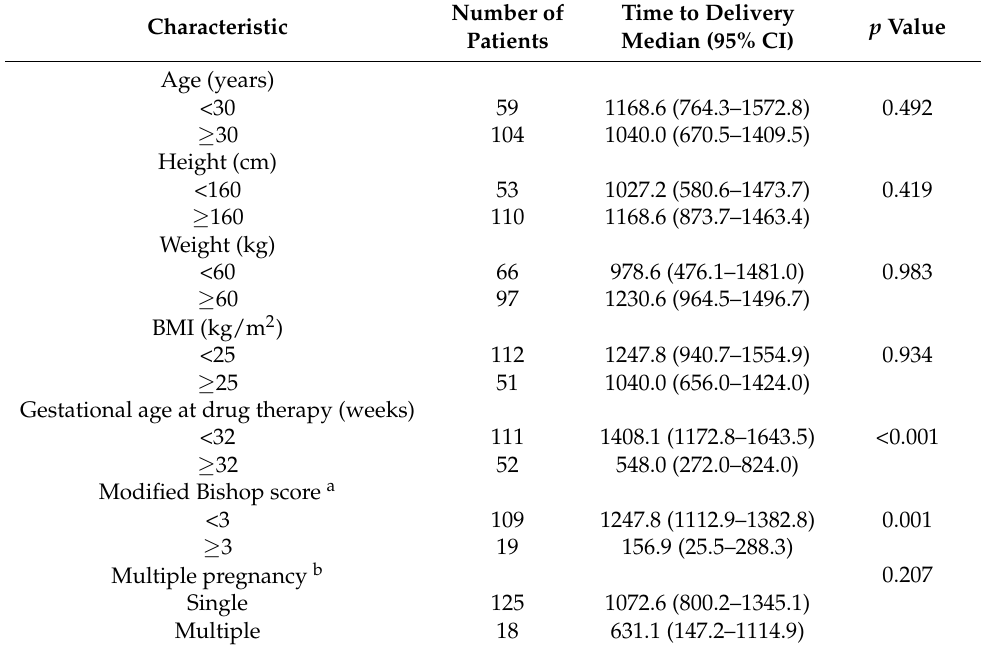
Table 1. Effects of demographic characteristics on time to